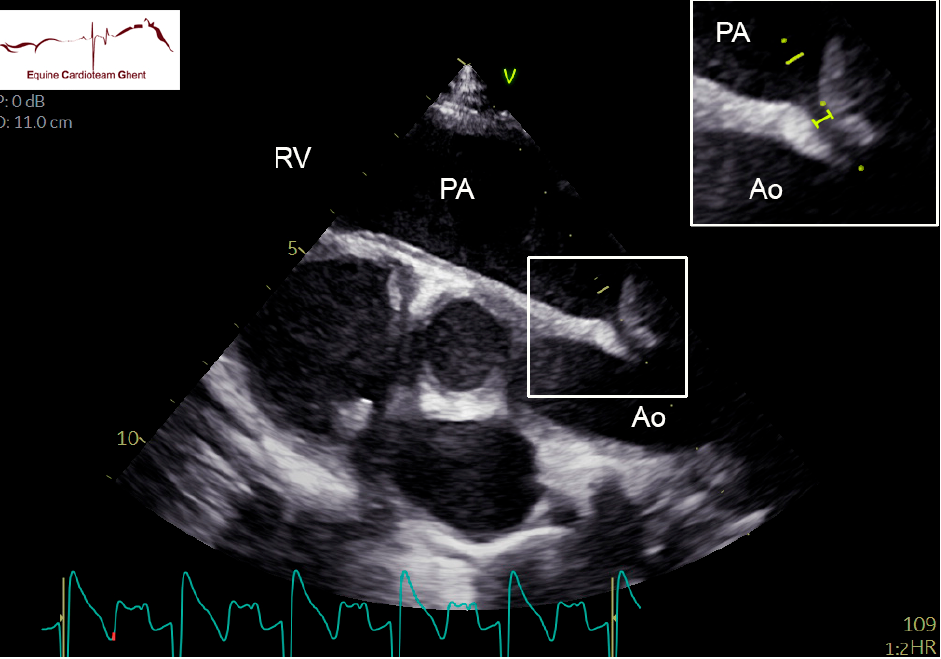
Figure 3. Left parasternal long-axis view of the pulmonary artery (PA) using slight dorso-caudal probe angulation in a 2-day-old healthy foal. The internal diameter of the ductus arteriosus is indicated by the yellow bar on the picture insert. The yellow dots indicate the cursos placement for continuous wave Doppler examination. Ao: aorta; PA: pulmonary artery; RV: right ventricle.